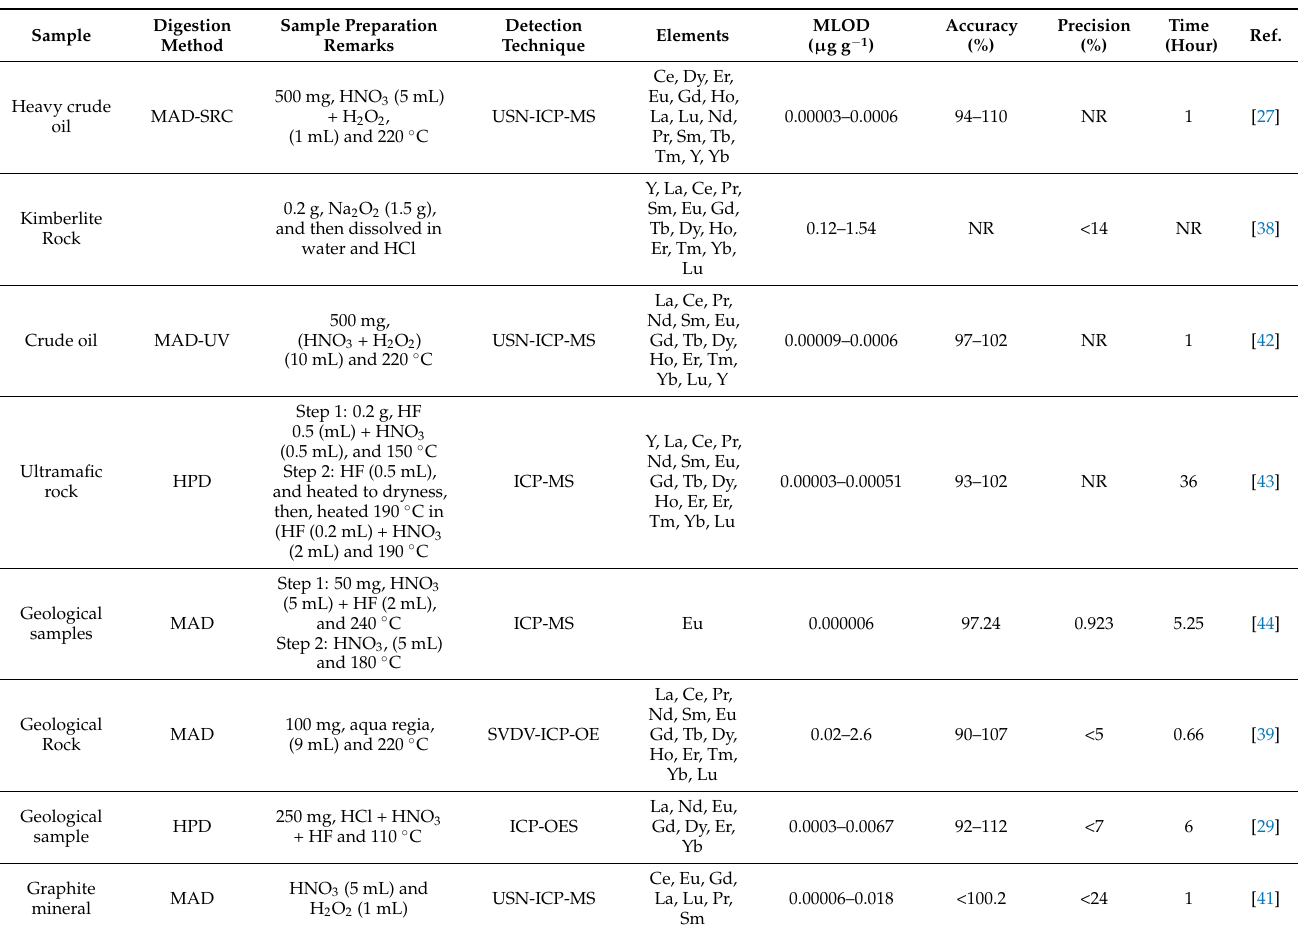
Table 5. Comparison of MAA-UAE analytical figures of merit with literature related sample preparation